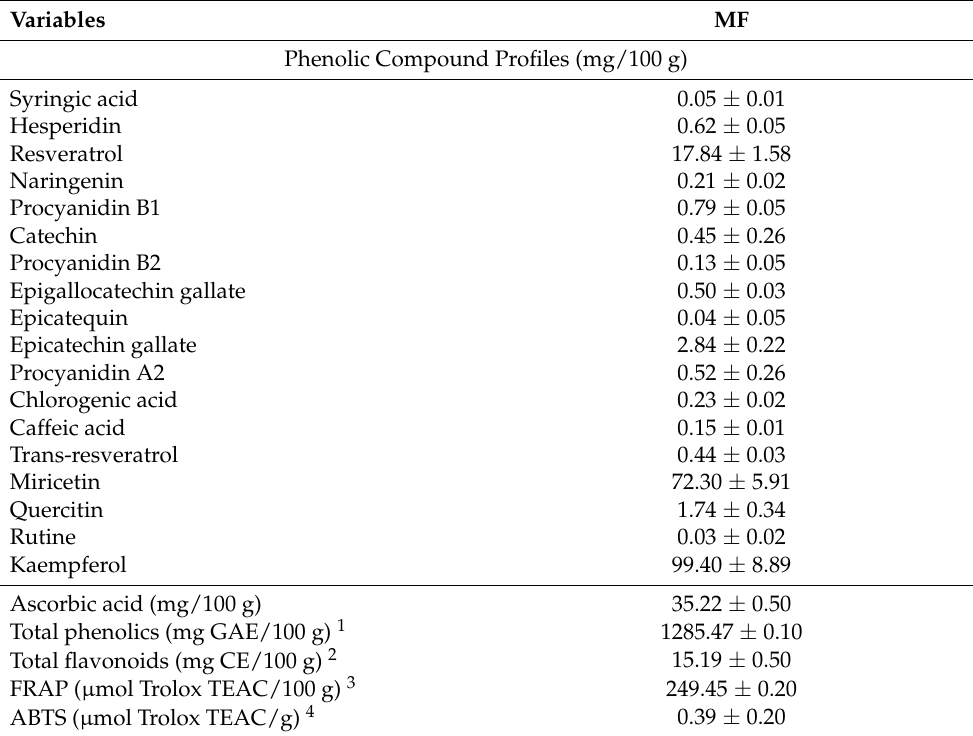
Table 4. Bioactive antioxidant compound content and antioxidant activity (media ± standard deviation) of